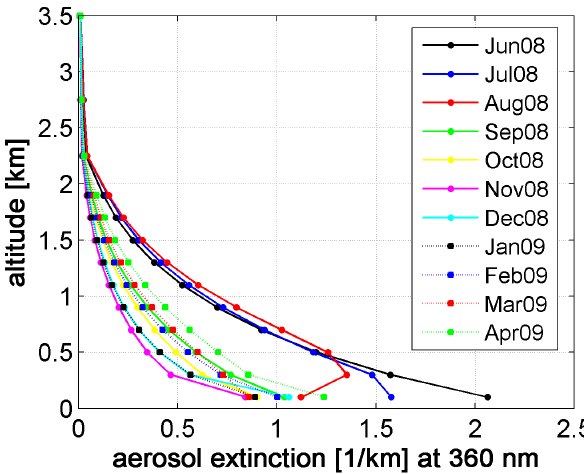
Fig. 9. Monthly mean aerosol extinction profiles at 360nm retrieved from the MAXDOAS measurements made in Beijing from June 2008 to April